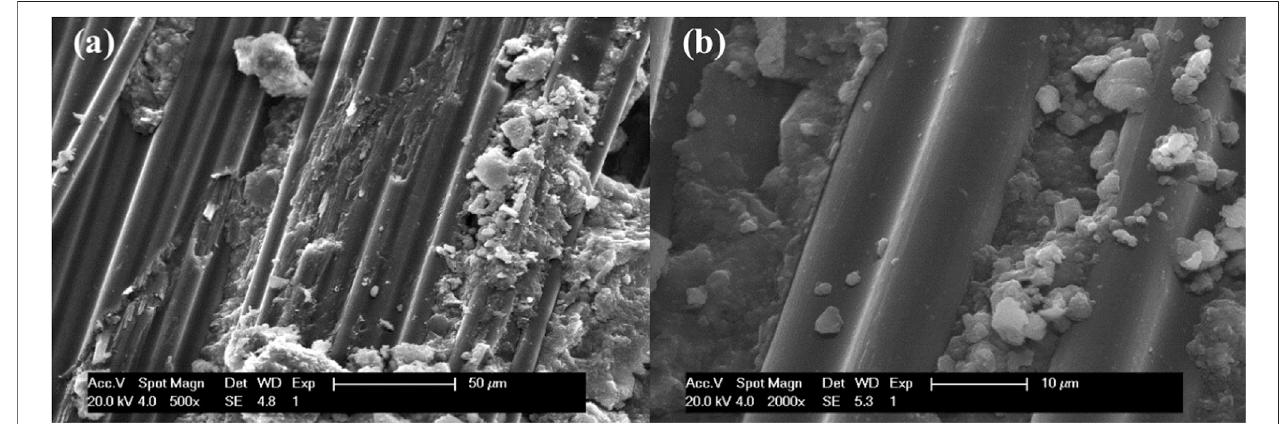
FIGURE 10 | Fracture surface of (A) BA25-W_CF/EP6 and (B) BA50-W_CF/EP6.